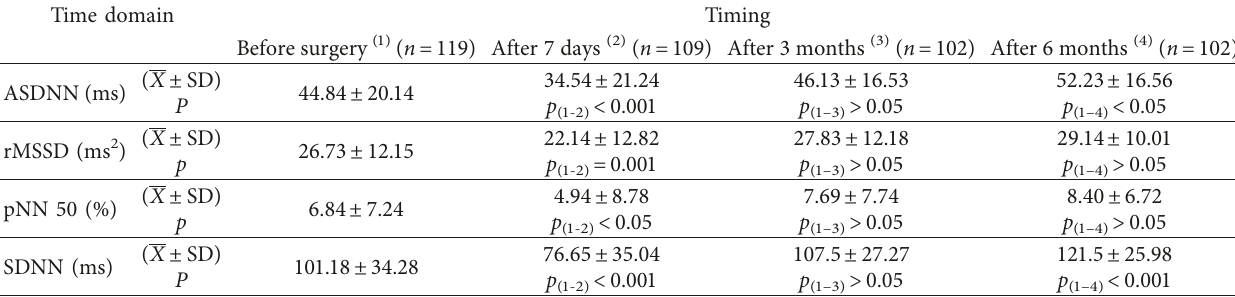
Table 3: Heart rate variability (HRV) in time domain before and after surgery.